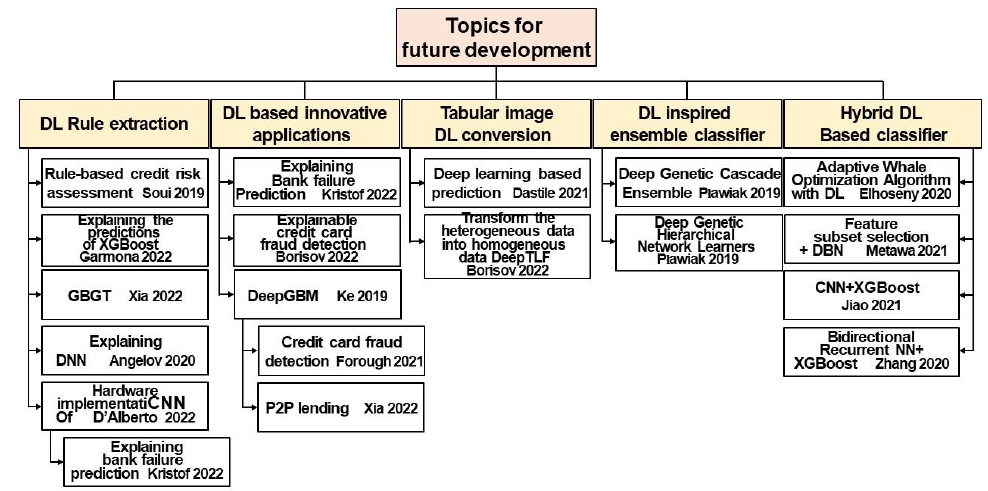
Figure 17. Treediagramoftopicsforfuturedevelopment Figure 17. Tree diagram of topics for future development.